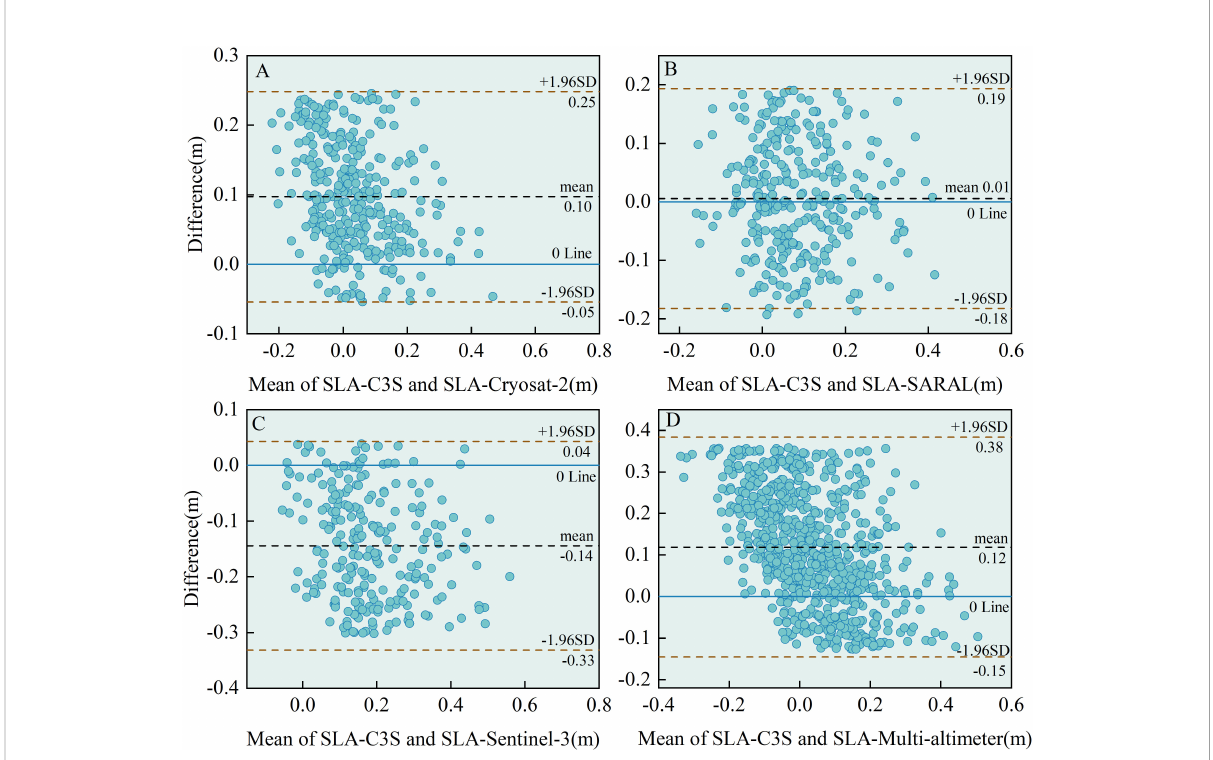
FIGURE 7 The Bland – Altman plots present the agreement between altimeter-based water levels and C3S SLA products during 2011 – 2021. (A) Cryosat-2, (B) SARAL, (C) Sentinel-3, (D) Multi-altimeter. Dashed, black line in the center of the plot presents mean value of the above described differences, and outer dashed yellow lines presents 95% level of agreement (mean − 1.96 standard deviation and mean + 1.96 standard